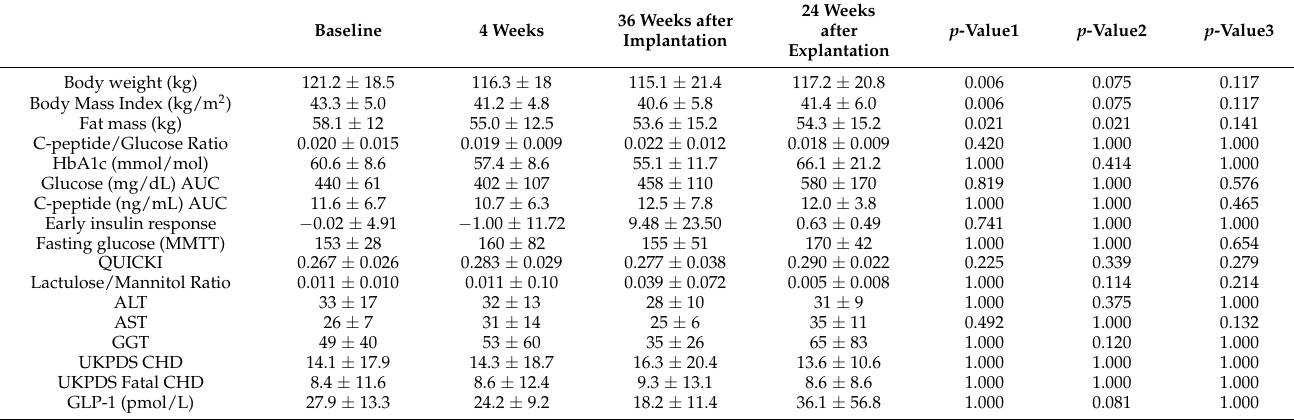
AUC: Area under the Curve; ALT: Alanine transaminase; AST: Aspartate aminotransferase; GGT: Gamma-glutamyl transferase; p -value1: Comparison Baseline vs. 4 Weeks; p -value2: Comparison Baseline vs. 36 weeks; p -value3: Comparison Baseline vs. 24 weeks